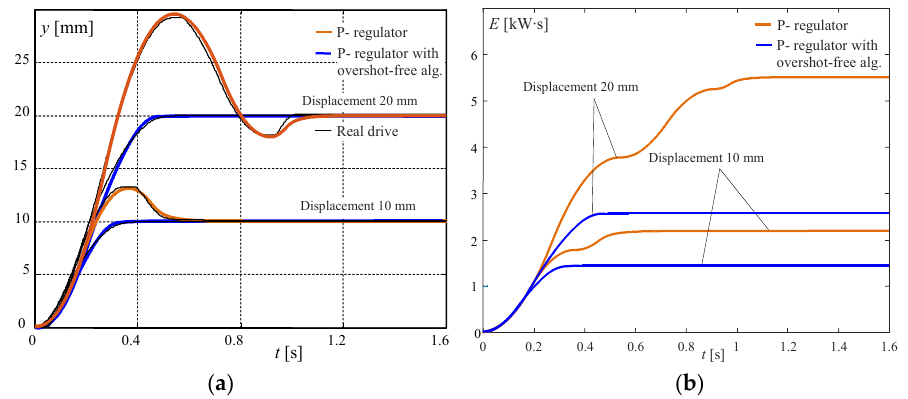
Figure 11. Comparison of P-type regulator and P-type with overshot-free algorithm. ( a ) Step responses of the servo drive with one stepping motor. ( b ) Energy losses on a valve.